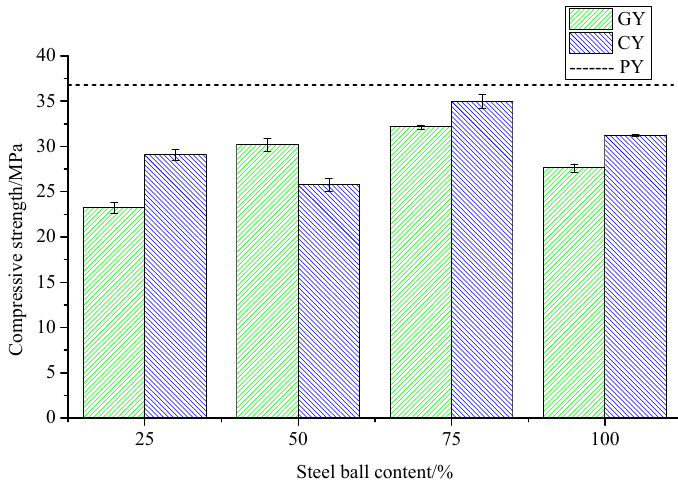
Figure 4. Change of compressive strength of grouted steel ball concrete. Table 8. Splitting tensile strength of grouted steel ball concrete.